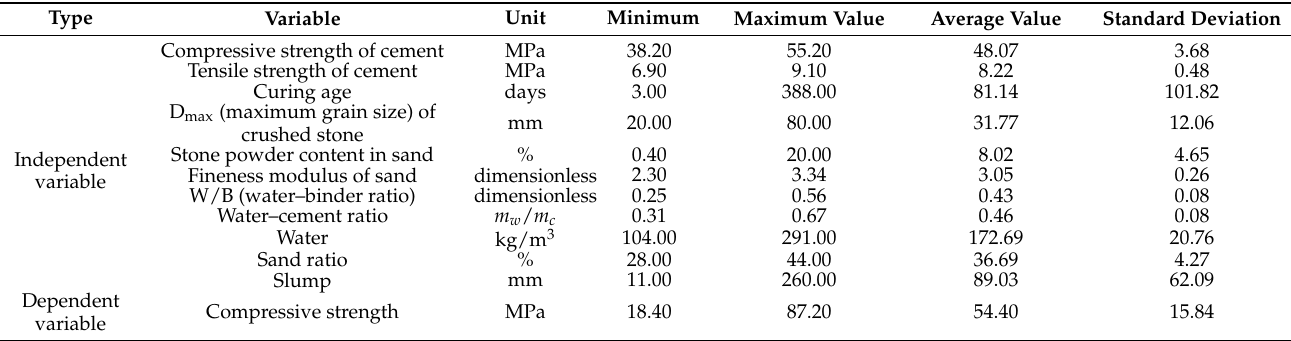
Table 5. Statistical information for the MSC dataset (data source: [48]).